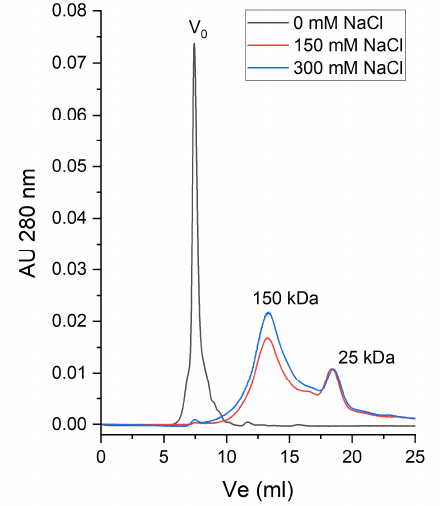
Figure 5. Chromatograms of SEC using a Superdex S200 10/300 GL column (30 cm × 10 mm) of the soluble forms of β-vignin at pH 9.0 containing or not increasing NaCl concentrations. For each run, 50 µ g of β -vignin (0.5 mg/mL) was loaded. Calibration of the column with standard proteins was performed in order to determine molecular weights of the eluting peaks. The used proteins and their elution volumes were the following: thyroglobulin (MW 670 kDa) Ve = V0 = 7.6 mL; ferritin (MW 440 kDa) Ve = 10 mL; alcohol dehydrogenase (MW 141 kDa) Ve = 13 mL; bovine serum albumin (MW 67 kDa) Ve = 14.5 mL; trypsin (MW 23.3 kDa) Ve = 17.5 mL.